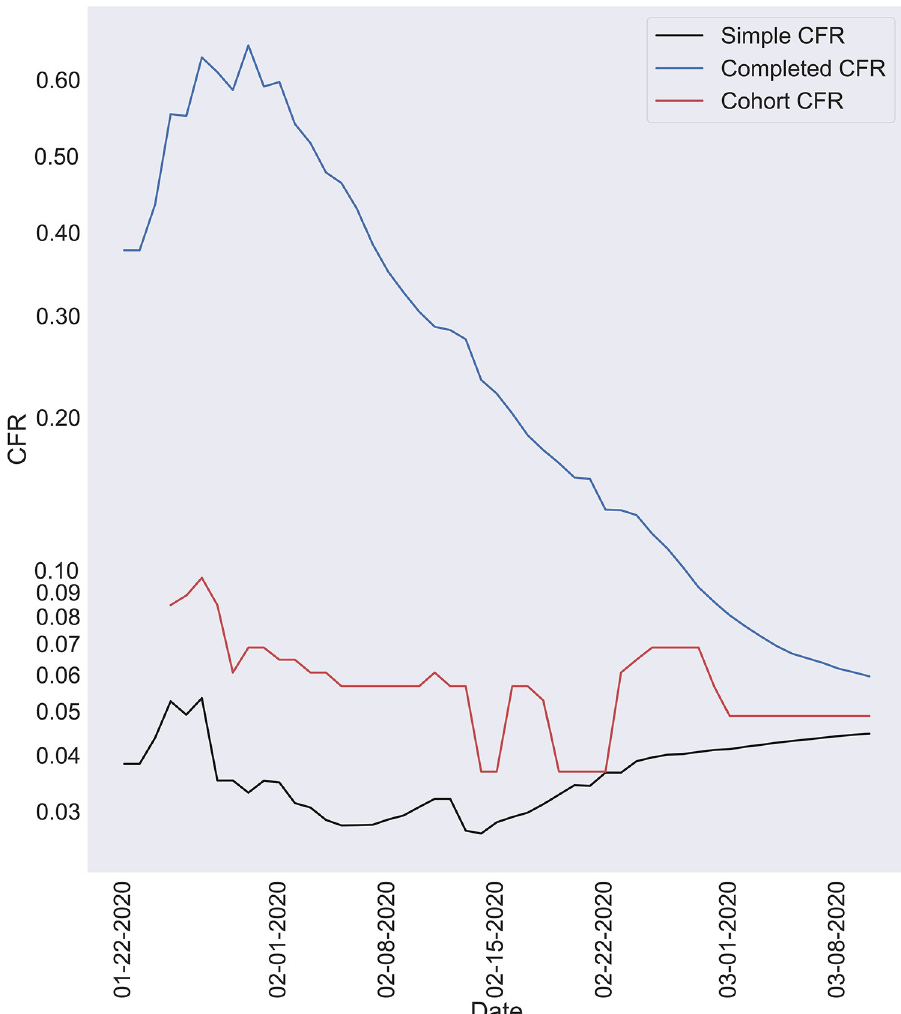
Fig 5. Comparison of CFR calculated with 3 methods. The three methods: completed CFR (deaths/ (deaths + recovered)); the simple CFR (deaths/confirmed); the cohort-based CFR defined in this work. Onset-to-death interval and case fatality rate that yield the best